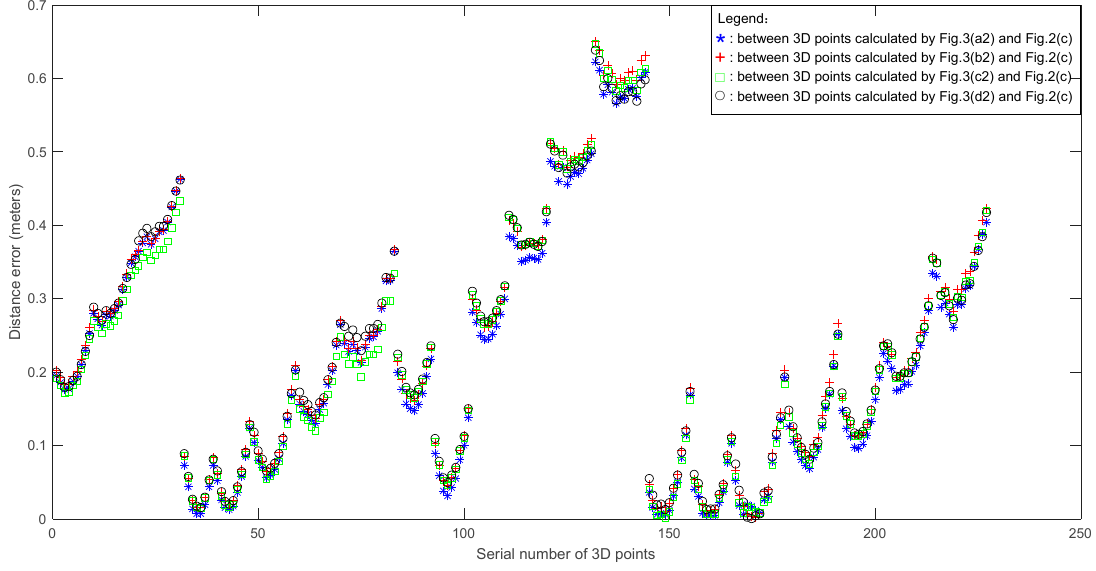
Figure 5. Distance errors of 3D points calculated by Figure 3(a2–d2) between the calculated and true values.